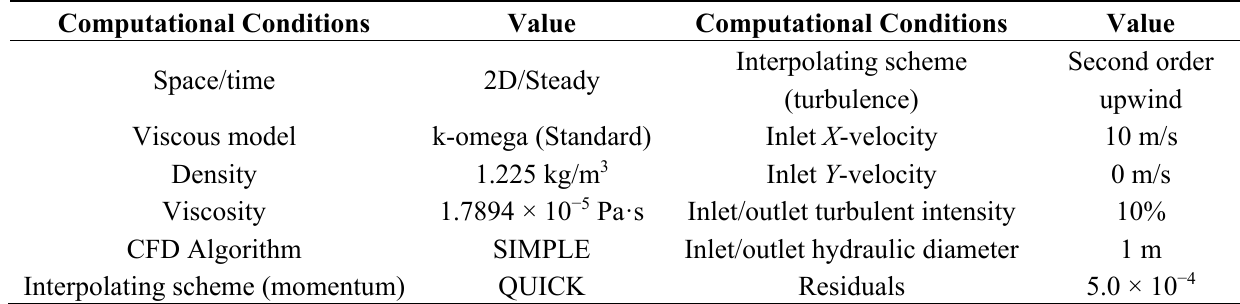
Table 1. CFD simulation conditions for the guide vane